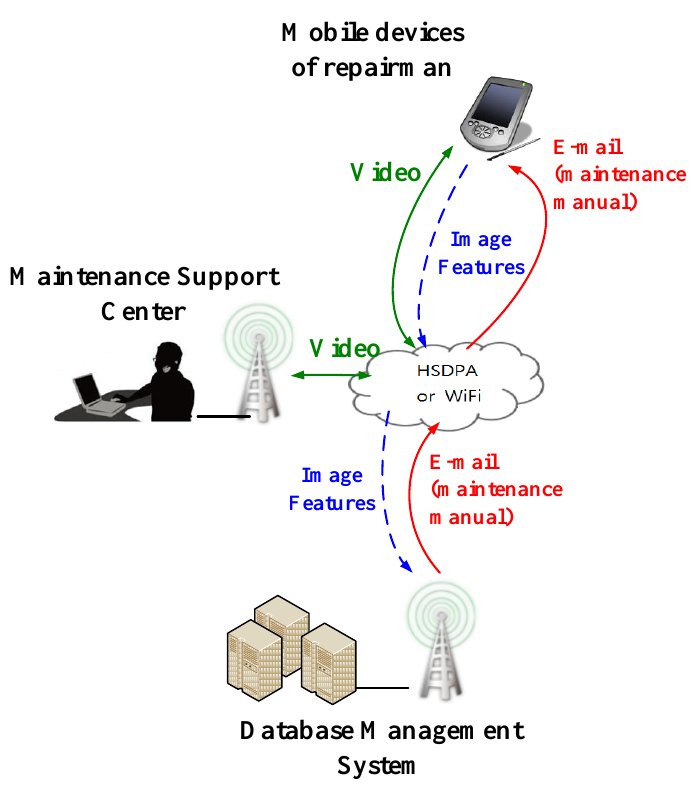
Figure 1. Logistical Remote Association Repair